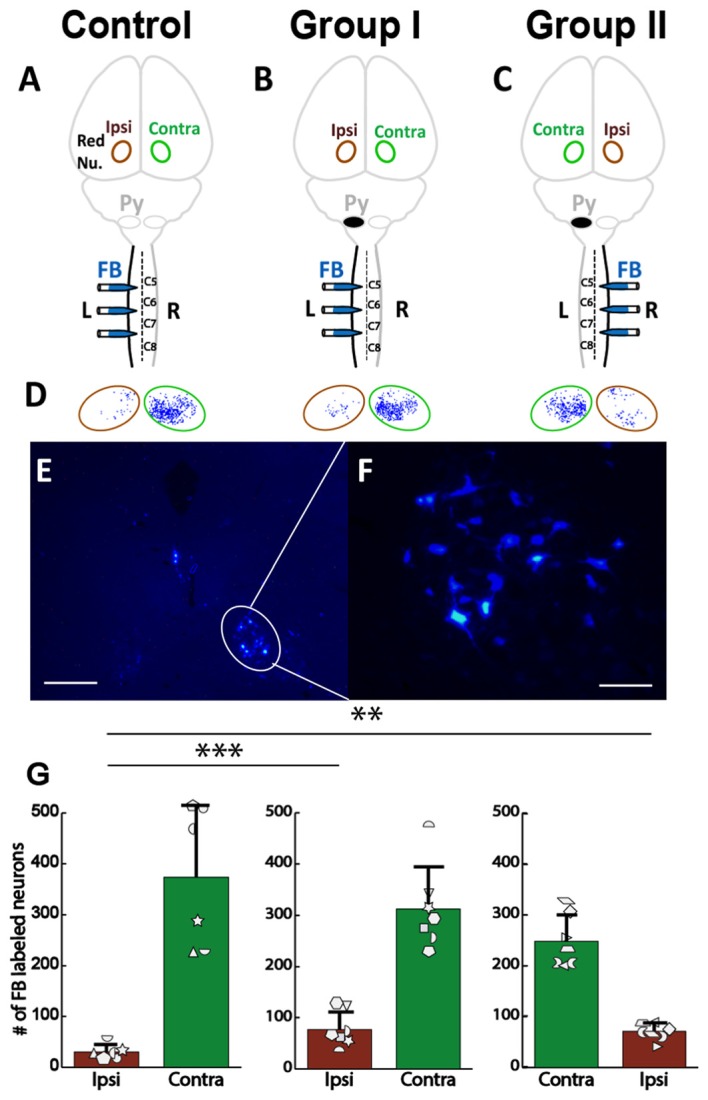
No increase in rubrospinal connections in the corticoRST circuit. (A–C) Experimental schema of injections of FB, pyramid (Py) cut, and analysis of the red nucleus (Red Nu.) sites. (A) Control with FB injection into the left side of the spinal cord; (B) Group I with FB injection into the left side (unimpaired) of the spinal cord. (C) Group II with FB injection into the right side (impaired) of the spinal cord. We analyzed the FB-labeled neurons in both the contralateral (Contra) and the ipsilateral (Ipsi) red nucleus of the control and the rats with neonatal pyramidotomy. (D,E) FB-labeled neurons in the red nucleus. Bar = 250 μm (D) or 50 μm (E). (F) Maps of distribution of the FB-labeled neurons in the red nucleus in the Control, Group I and Group II. Green circles represent the contralateral (to the injection) red nucleus, and the brown circles the ipsilateral red nucleus. (G) The mean number of the FB-labeled neurons in the red nucleus. Note that no significant differences were detected in the contralateral red nucleus (green bars) among three groups; however, a significant increase was noted in the ipsilateral red nucleus after neonatal pyramidotomy in comparison to the Control (brown bars). There was no difference in the contralateral or in the ipsilateral red nucleus between Group I and Group II. Plotted white shapes correspond to each rat’s data points. Each rat’s data in the Control group, Group I, and Group II were represented by a particular shape. **p < 0.01, ***p < 0.005.